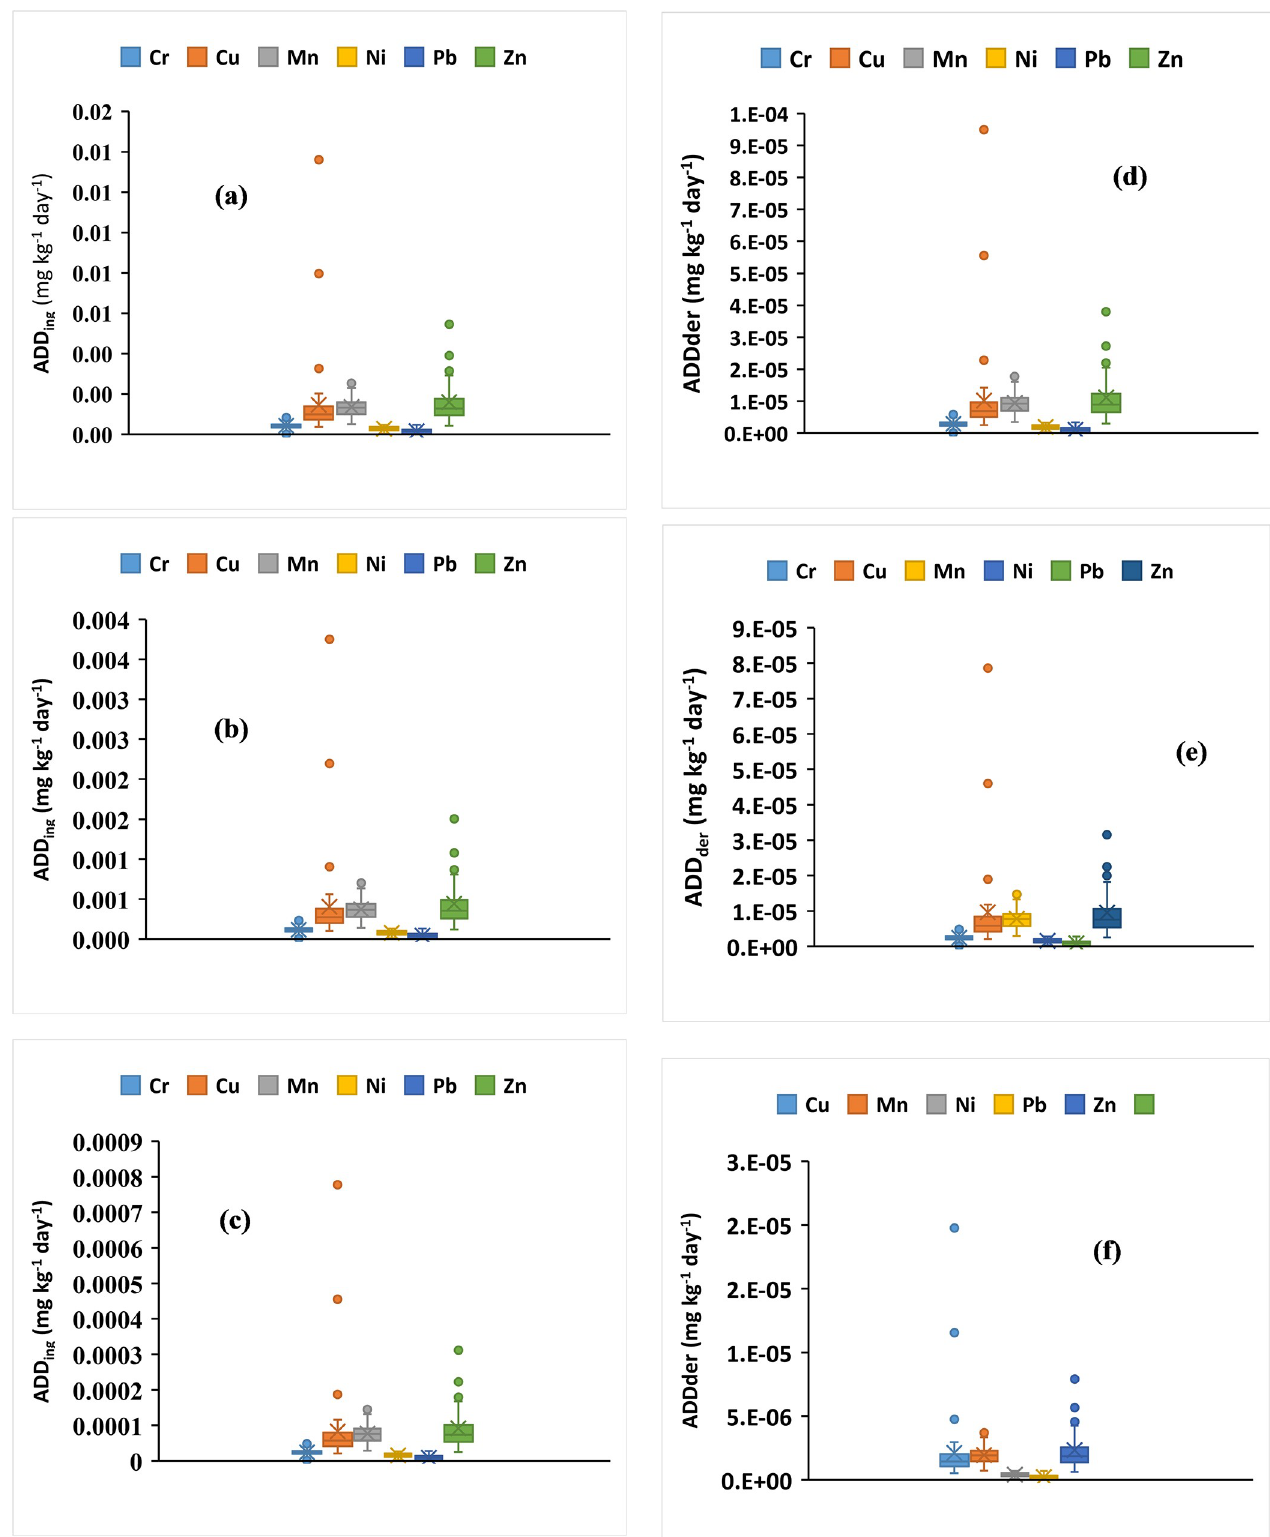
Fig 4. Average daily dose exposure via ingestion in (a) less than 6 years children (b) 6 to 12 years (c) more than 12 years, Average daily dose exposure via dermal in (d) less than 6 years children (e) 6 to 12 years (f) more than 12 years. https://doi.org/10.1371/journal.pone.0261957.g004 PLOS ONE | https://doi.org/10.1371/journal.pone.0261957 January 6,